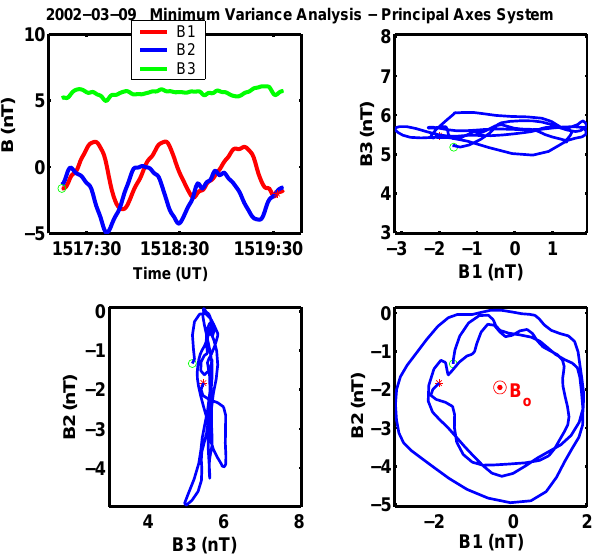
Fig. 3. Principle axis components (upper left) and corresponding hodograms of the low-frequency wave magnetic field in the prin- cipal axes coordinates derived from a minimum variance analysis for the event shown in Fig. 1. Open circles (asterisks) indicate the beginning (end) of each